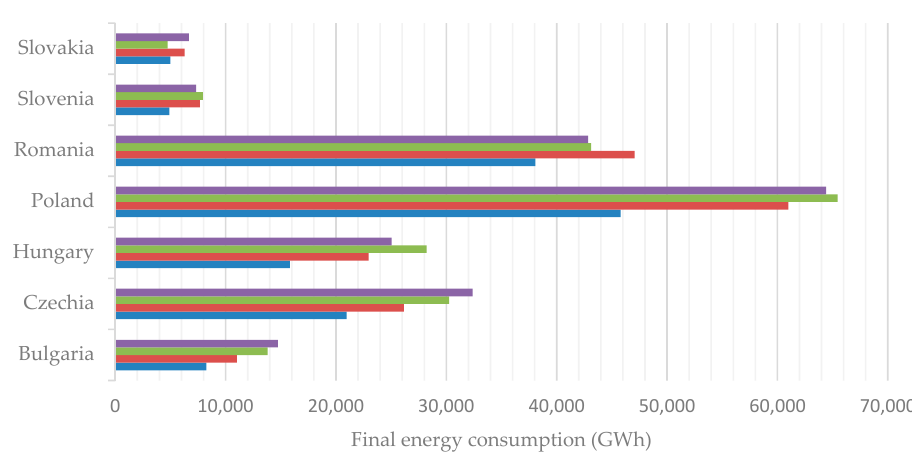
Figure 10. Final energy consumption (GWh), Source: Own representation based on World Bank data [24].